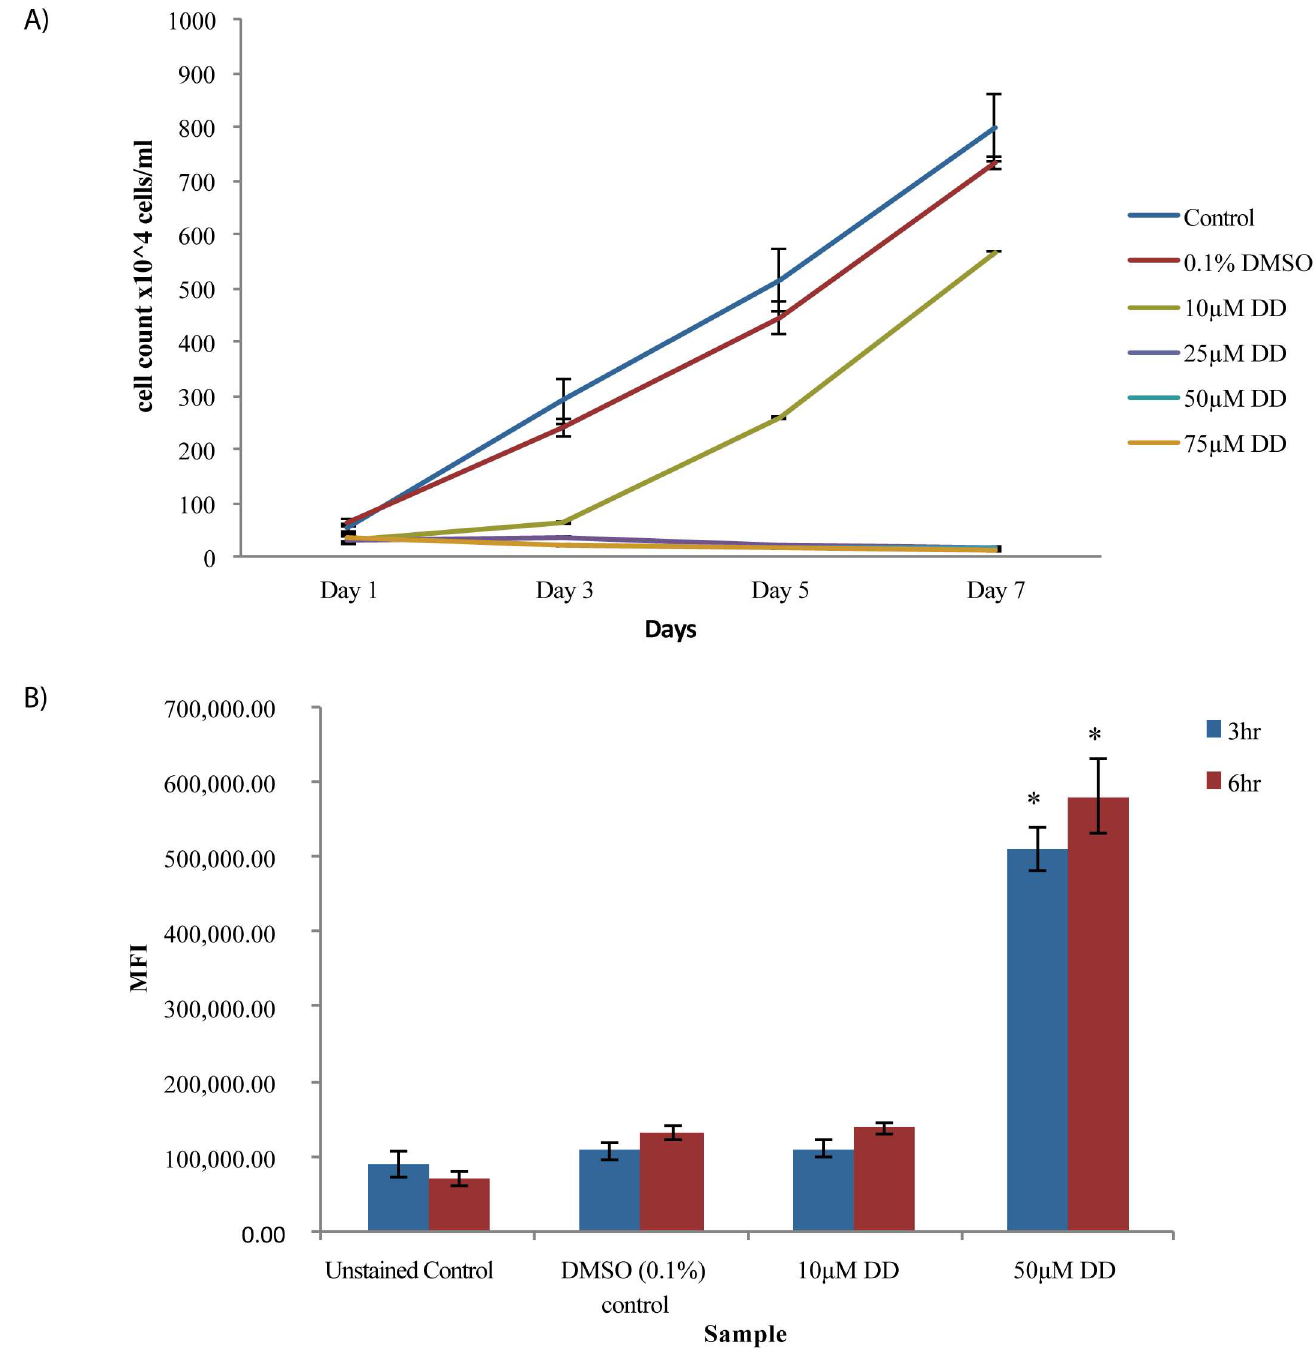
Fig 1. Effects of DD concentration on cell growth and viability. (A) Cell densitieswere measuredwith a hemocytometer. Error bars represent standarderror. Significance calculatedusing student’st-test, P < 0.05 for 25 µ M, 50 µ M and 75 µ M DD with respect to DMSO solvent control and P > 0.05 for 10 µ MDD with respect to DMSO solvent control; n = 3. Representative data from three independentexperiments are shown. (B) Measurement of viabilityin cells treated with DMSO and DD dose for the times indicated(hr). Cell accumulationof Sytox Green fluorescent dye was measuredby flow cytometry. MFI is Median Fluorescence Intensity. Error bars represent standarderror. Changeswith 50 µ M DD were found significantwith respect to DMSO solvent control, student’sT-test, * p < 0.05;n = 3.